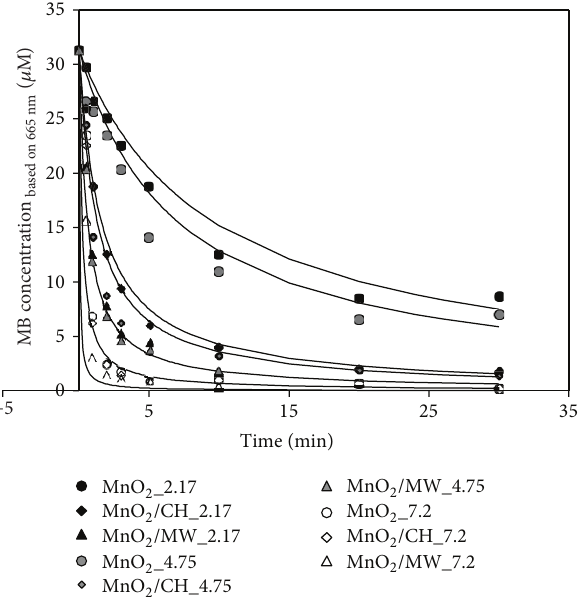
F 3: Kinetics of MB degradation and the third-order kinetic model (line).